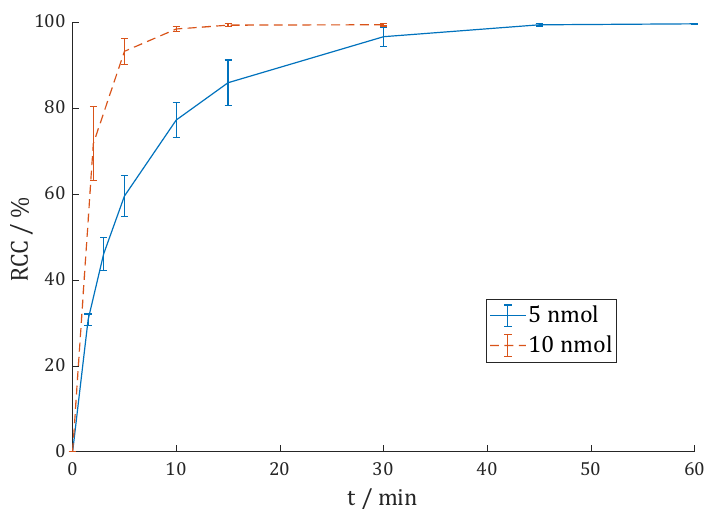
Figure 8. Reaction kinetics (radiochemical conversion (RCC) in %) of [ 90 Y]Y-DO3A.Glu.(FAPi) 2 90 Y-11 in 1 M HEPES (pH = 4.5) at 95 ◦ C with 30–60 MBq 90 Y (n = 3).